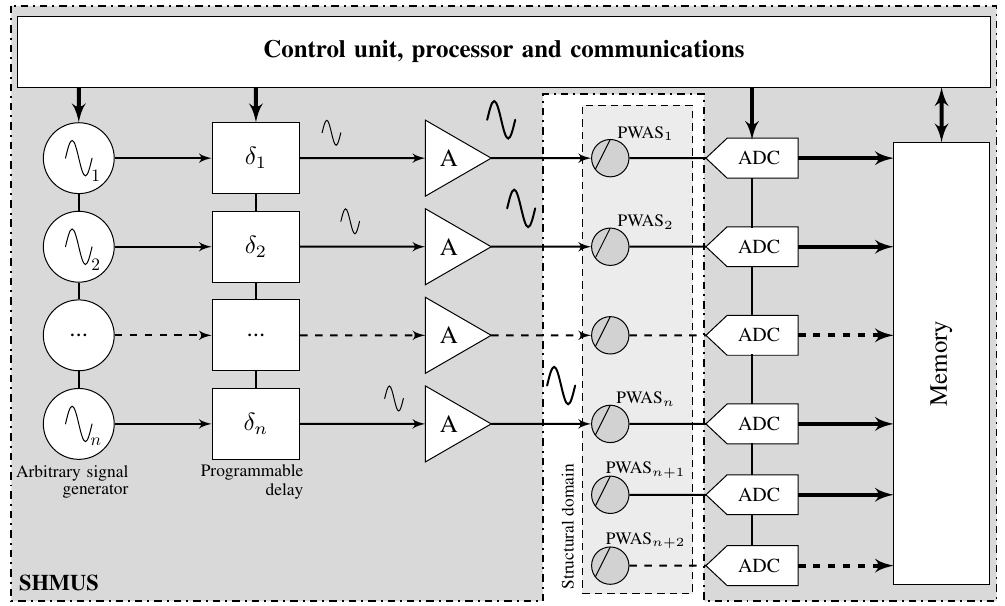
Figure 3. Generic scheme of the hardware needed to carry out transmission beamforming. PWAS 1,2, . . . , n are used in pulse-echo mode. Besides, PWAS n + 1, n + 2, . . . are operated in pitch–catch